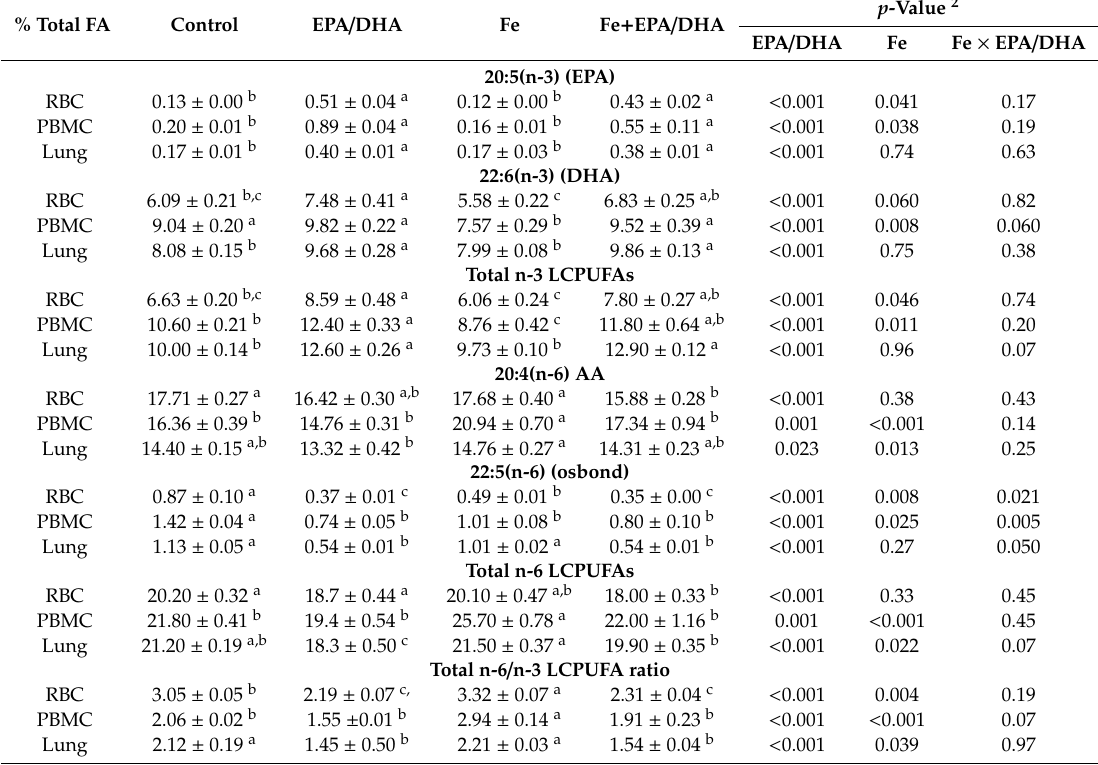
Table 2. Phospholipid FA composition of RBCs, PBMCs, and crude lung homogenates in Mtb -infected mice receiving control, EPA / DHA, Fe, or Fe + EPA / DHA diets for three weeks 1